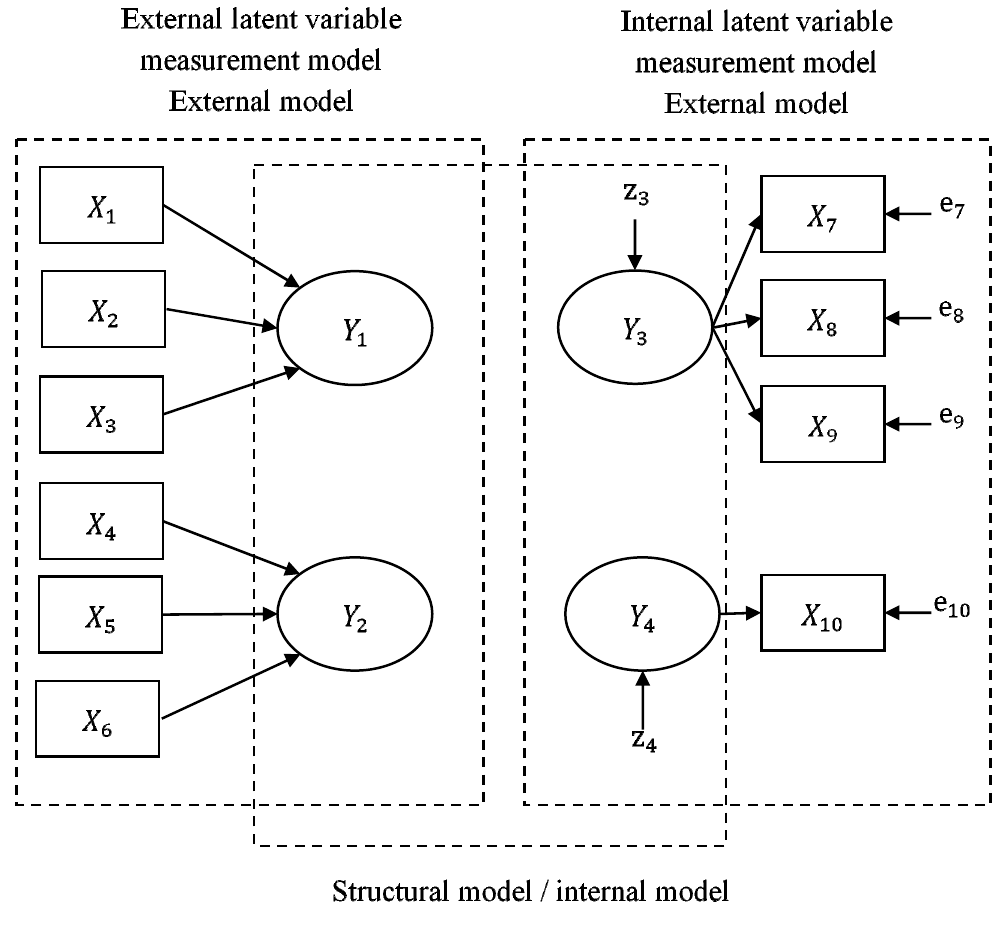
Figure 3. Simple path models [77].